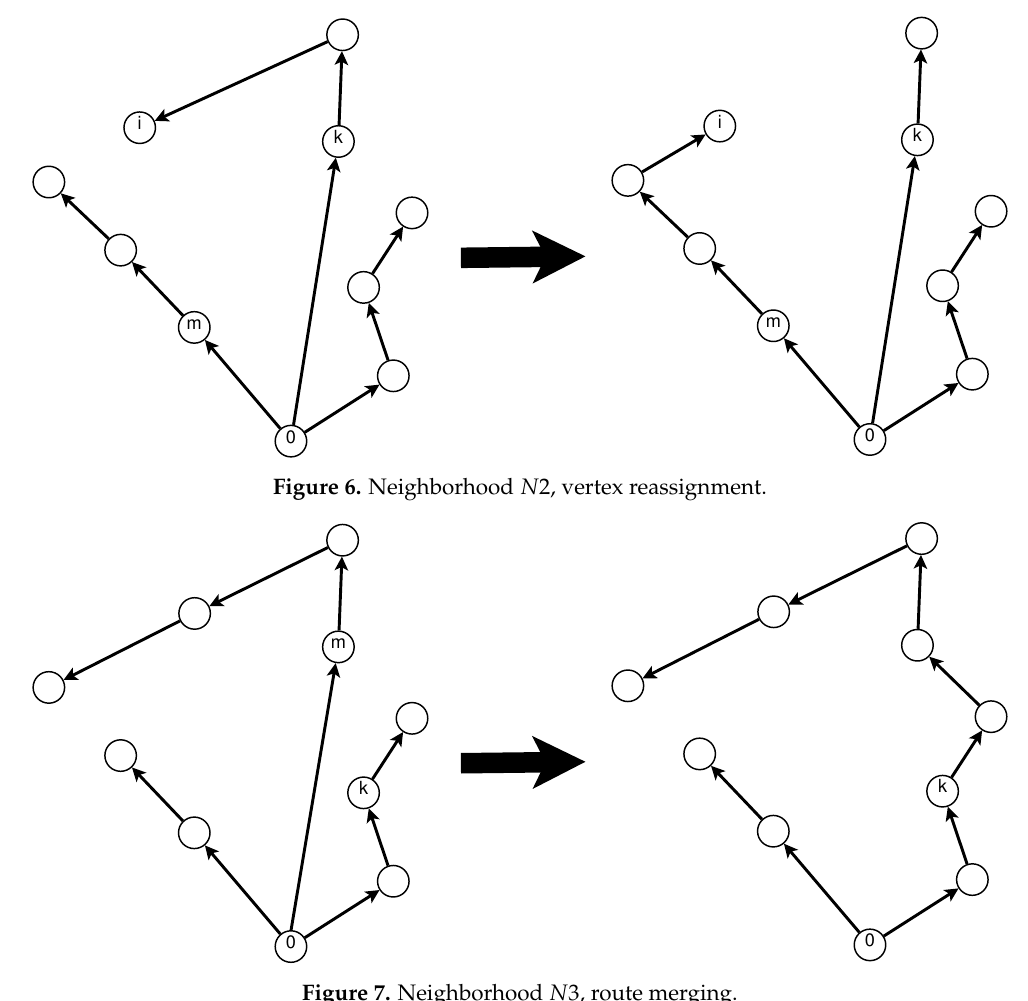
Figure 7. Neighborhood N 3, route